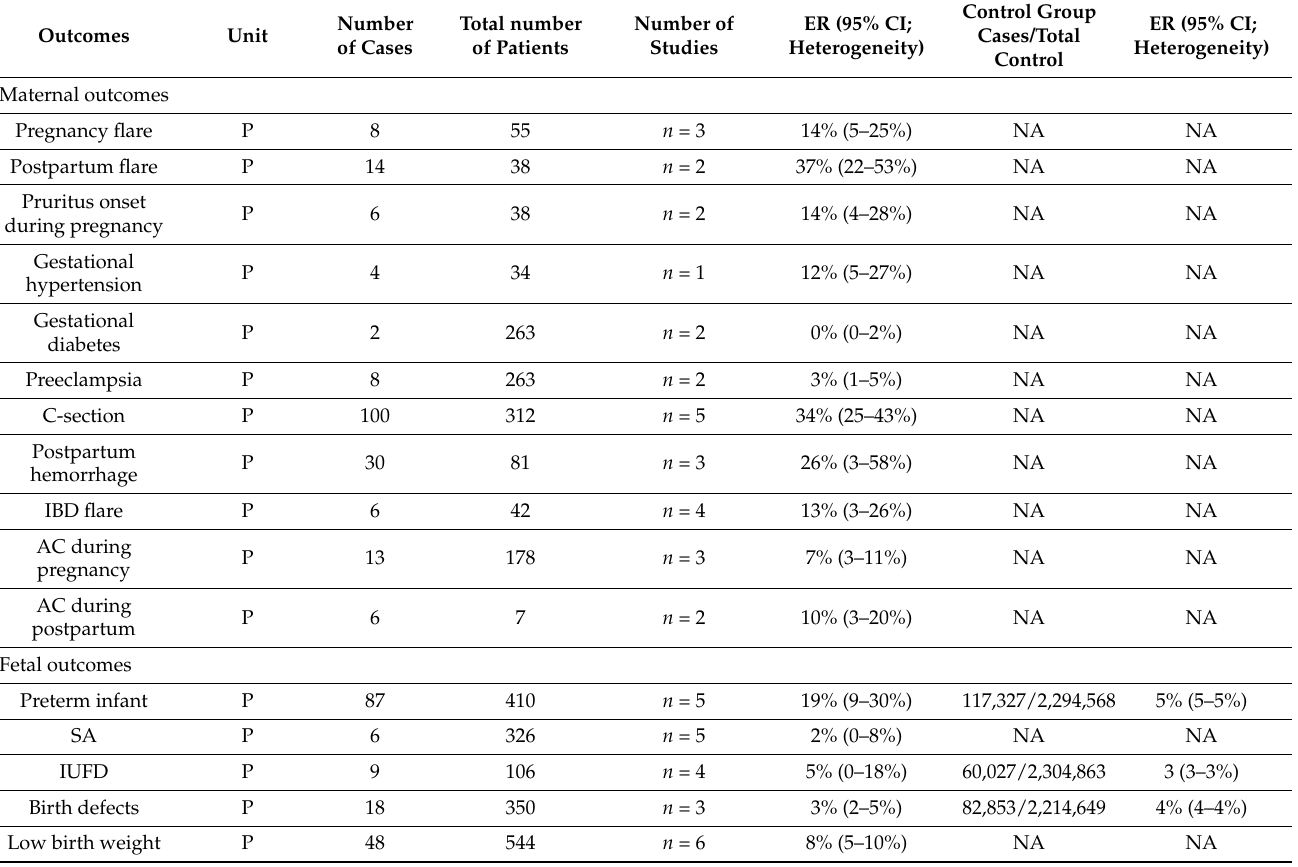
Table 4. Prevalence data of maternal and fetal outcomes in patients with primary scleros- ing